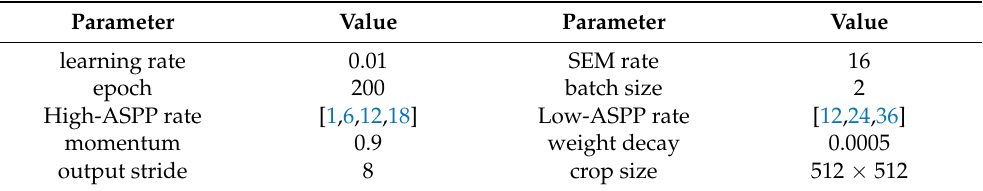
Table 3 below: Table 3. Training Table 3. Training parameters.